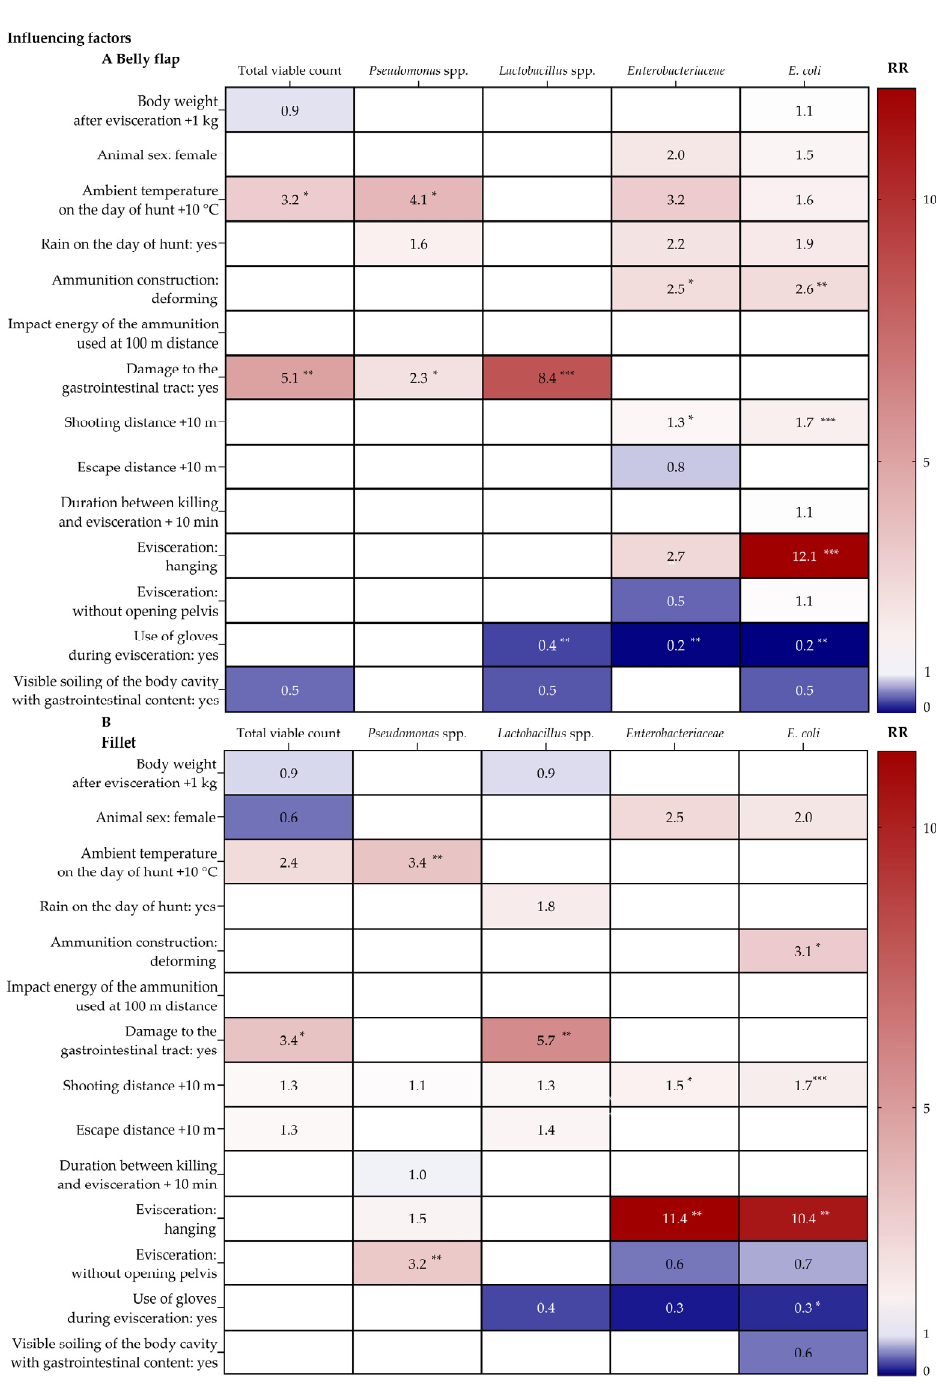
Figure 3. Heat maps for influencing factors (IFs) affecting initial microbial load (IML; total viable colony count, Pseudomonas spp., Lactobacillus spp., Enterobacteriaceae , E. coli ) of roe deer belly flap (( A ), n = 24) and fillet (( B ), n = 23) with resulting Rate Ratios (RRs) shown in each cell. The heat maps have been created using the RRs of variables identified as IFs by linear regression with backward selection. An RR of 1 were presented as empty cells and means no effect. Significance levels of RRs were highlighted by stars (* p < 0.05, ** p < 0.01, *** p < 0.001). To make the effect statements more tangible, RRs were calculated for ambient temperature, shooting distance, escape distance and duration between killing and evisceration in increments of